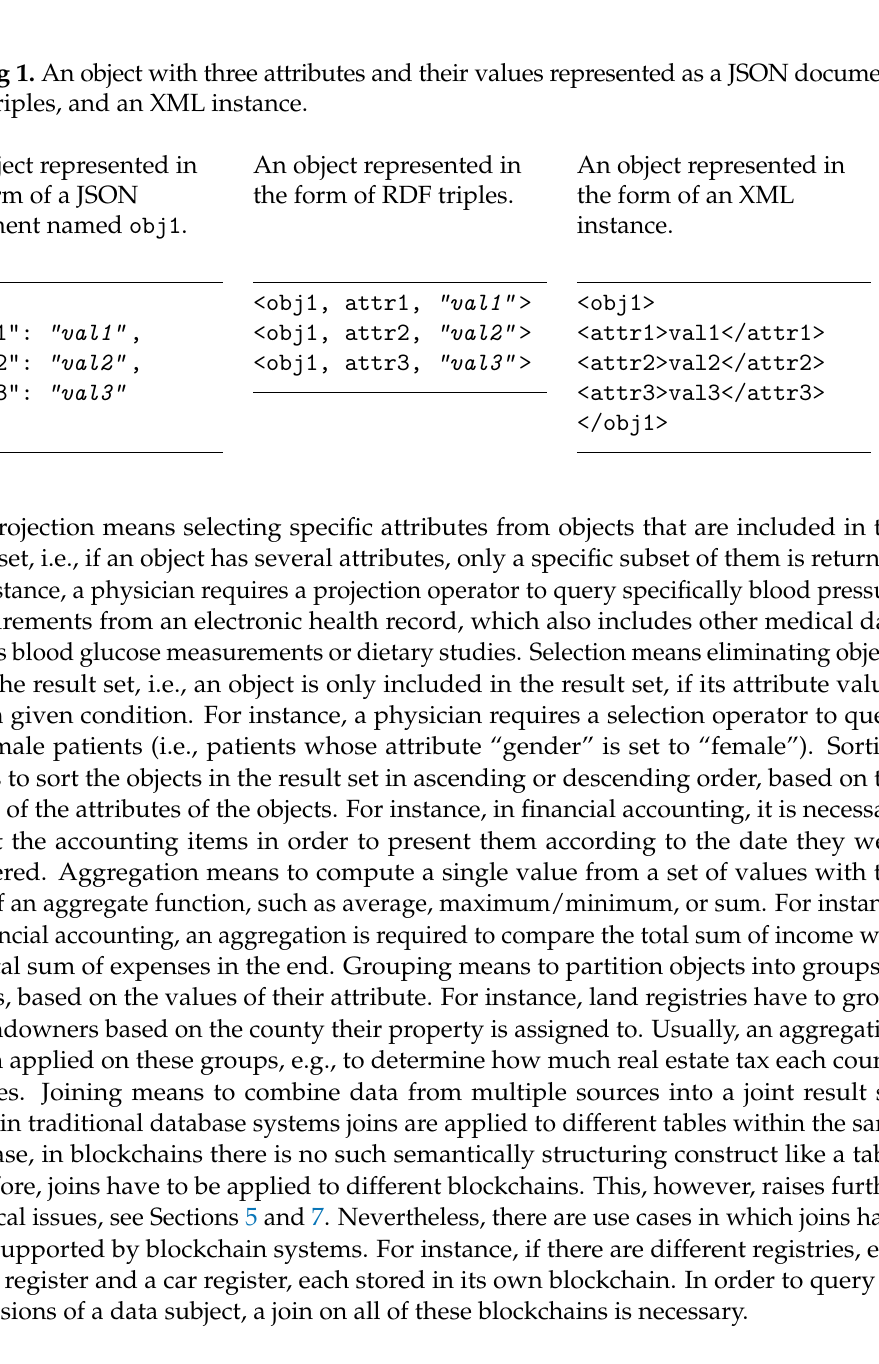
Expandable Object